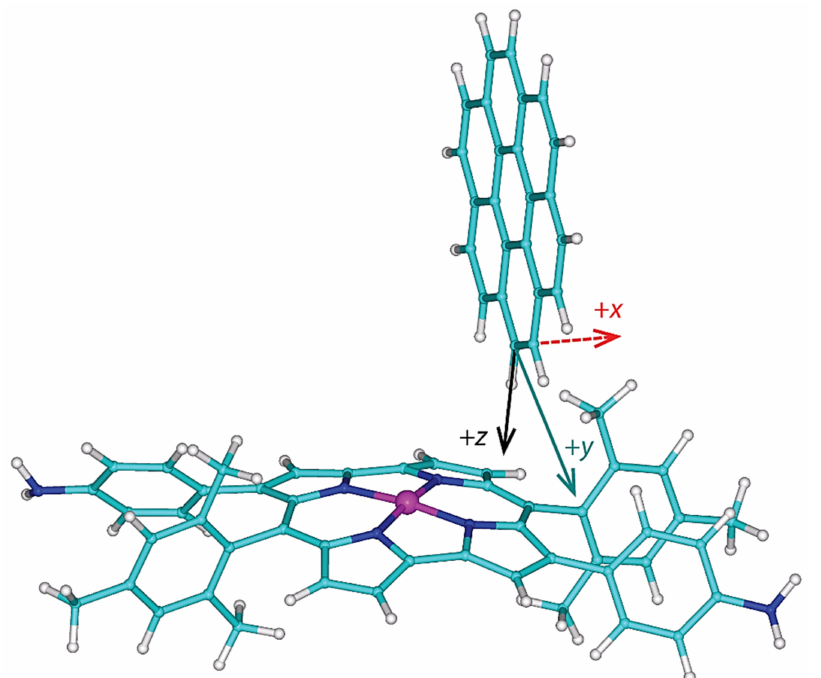
Figure 4. The investigated configuration of a complex formed between 3,12-di(4-aminophenyl) Ni II dimesitylnorcorrole and coronene. The coordinate system depicts the dorsal ( x ), lateral ( y ), and vertical ( z ) directions discussed in the